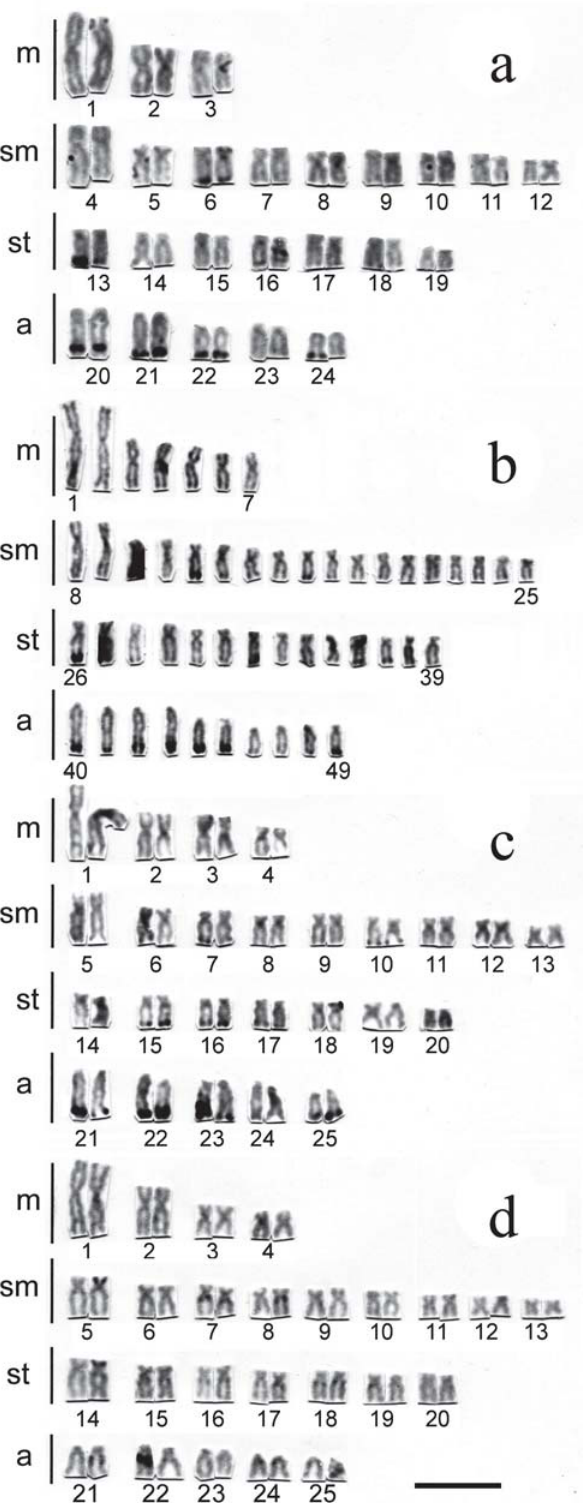
Fig. 3. C-banding karyotypes found in Astyanax aff . fasciatus of the upper rio Tibagi region (Ponta Grossa, Paraná State, Brazil). In (a), cytotype A (2n=48), in (b) karyotype of the specimen with 2n=49 chromosomes, presenting a C-banding pattern similar to cytotypes A and B, in (c) cytotype B (2n=50) and in (d) cytotype C (2n=50). Bar: